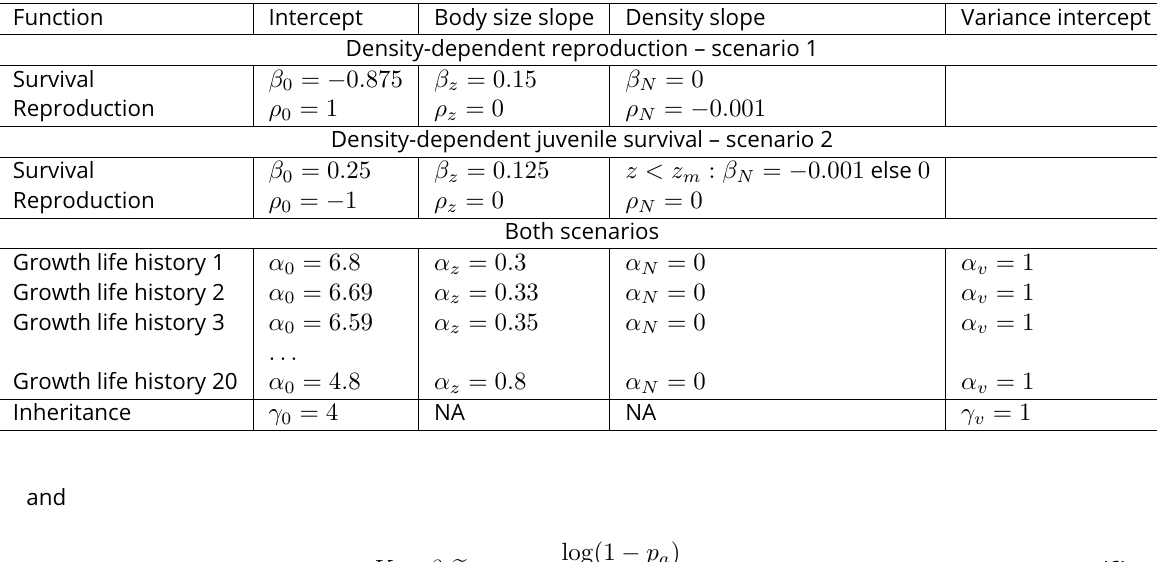
Table 2. Parameter values used in the two